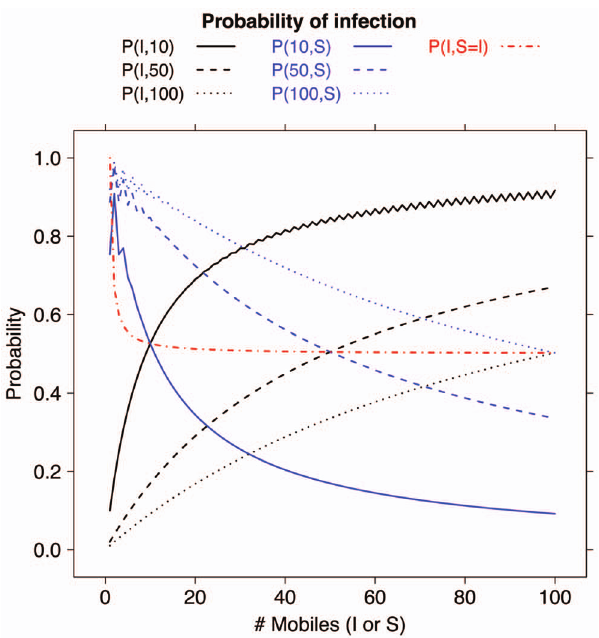
Figure 6. Plot of curves of P ( I , S ) for different configurations ( I , S ) . In blue, we show three curves of P ( I , S ) for constant I ( I ~ 10 solid line, I ~ 50 dashed line and I ~ 100 dotted line) and S ranging from 0 to 100. All three curves approach the asymptotic value 0 for increasing S , more rapidly for smaller values of I . In black, we show the symmetric cases obtained keeping S constant( S ~ 10 solidline, S ~ 50 dashedlineand S ~ 100 dotted line) and letting I range from 0 to 100. Again, all three curves approach the asymptotic value 1 for increasing I , more rapidly for smaller values of S . The sawtooth shape of the curve P ( I ,10) for I § 30 is due to the effect of the { case, which induces abrupt differences in P ( I , S ) for consecutive values of I (changing from even to odd). Finally, the dotted-dashed red line shows the curve of P ( I , S ) for I ~ S ranging between 0 and 100: in this case, the curve gets veryclosetoitsasymptoticvalue0.5evenwithsmallvalues of I ~ S ;for instance, P (10,10) ^ 0 : 52 and P (25,25) ^ 0 : 51 .